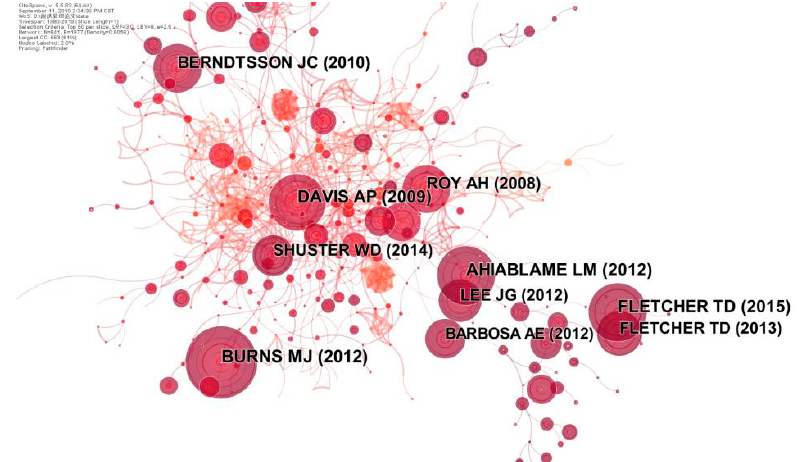
Figure 2. Co-citation of literature. Table 3. Top 10 frequently co-cited documents in stormwater management.